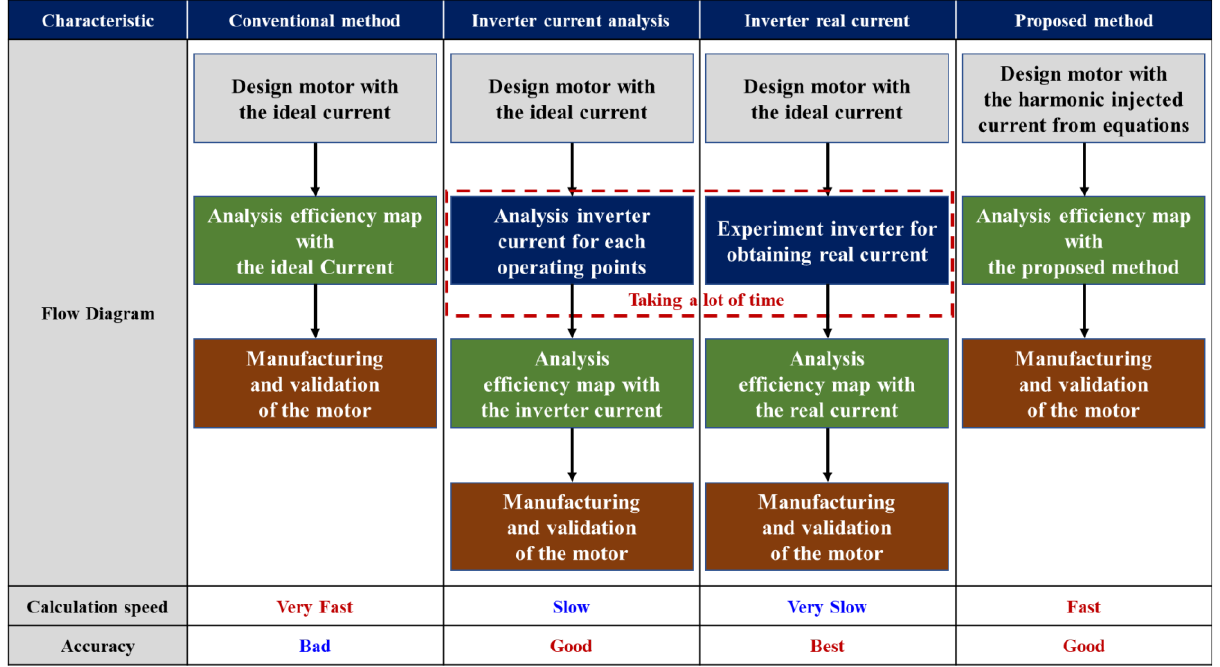
Figure 1. Characteristic comparison of the conventional methods with the proposed method.